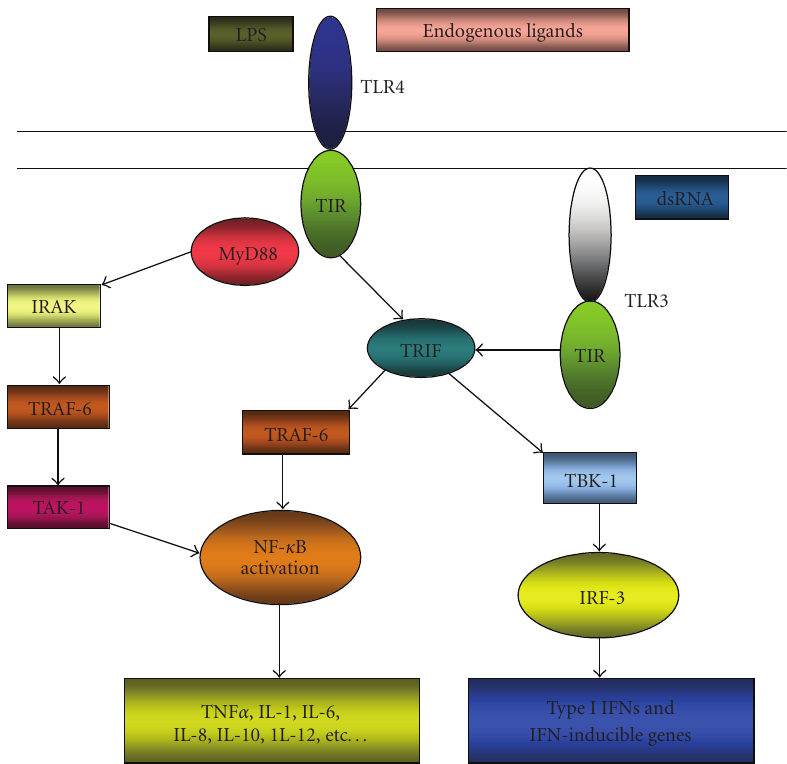
Figure 1: Toll-like receptor (TLR) signalling pathways. Membranal TLRs (represented by TLR4) recognize external ligands (exogenous and endogenous), while cytoplasmic TLRs (TLR3) recognize intracellular signals. When activated, the majority of TLRs induce activation of NF- κ B (early phase of NF- κ B activation) and cytokine production in a MyD88-dependent manner; while TLR4, like TLR3, can also signal in a MyD88-independent manner and induce the expression of type I interferons (IFN) and IFN-inducible proteins in addition to a late phase NF- κ B